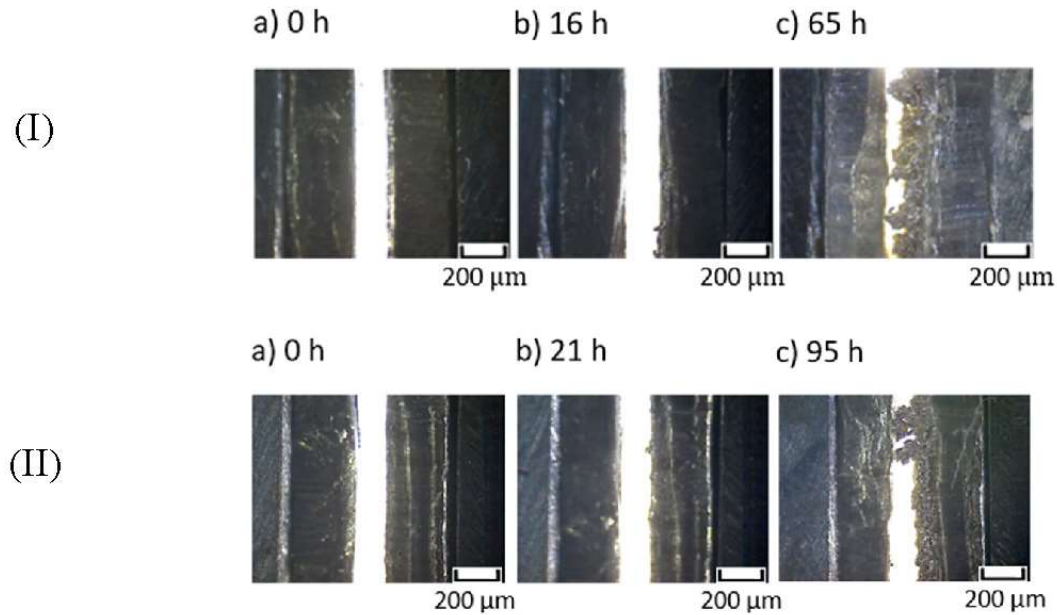
Figure 9. Dendrite growth in ( I ) Li|MEEP/LiBOB|Li and ( II ) Li|MEE- co -OBF 3 Li/LiBOB|Li visualization cell at 60 ◦ C and 0.1 mA · cm -2 ; ( a ) before polarization; ( b ) dendrite structures observed; ( c ) dendrite reached positive electrode and short-circuit the cell.